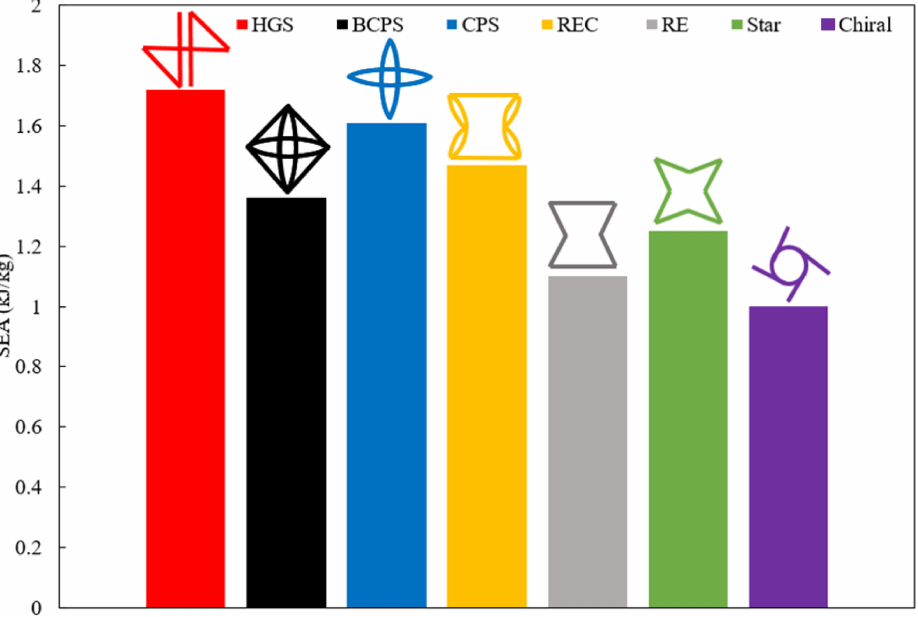
Figure 19. SEA values for different